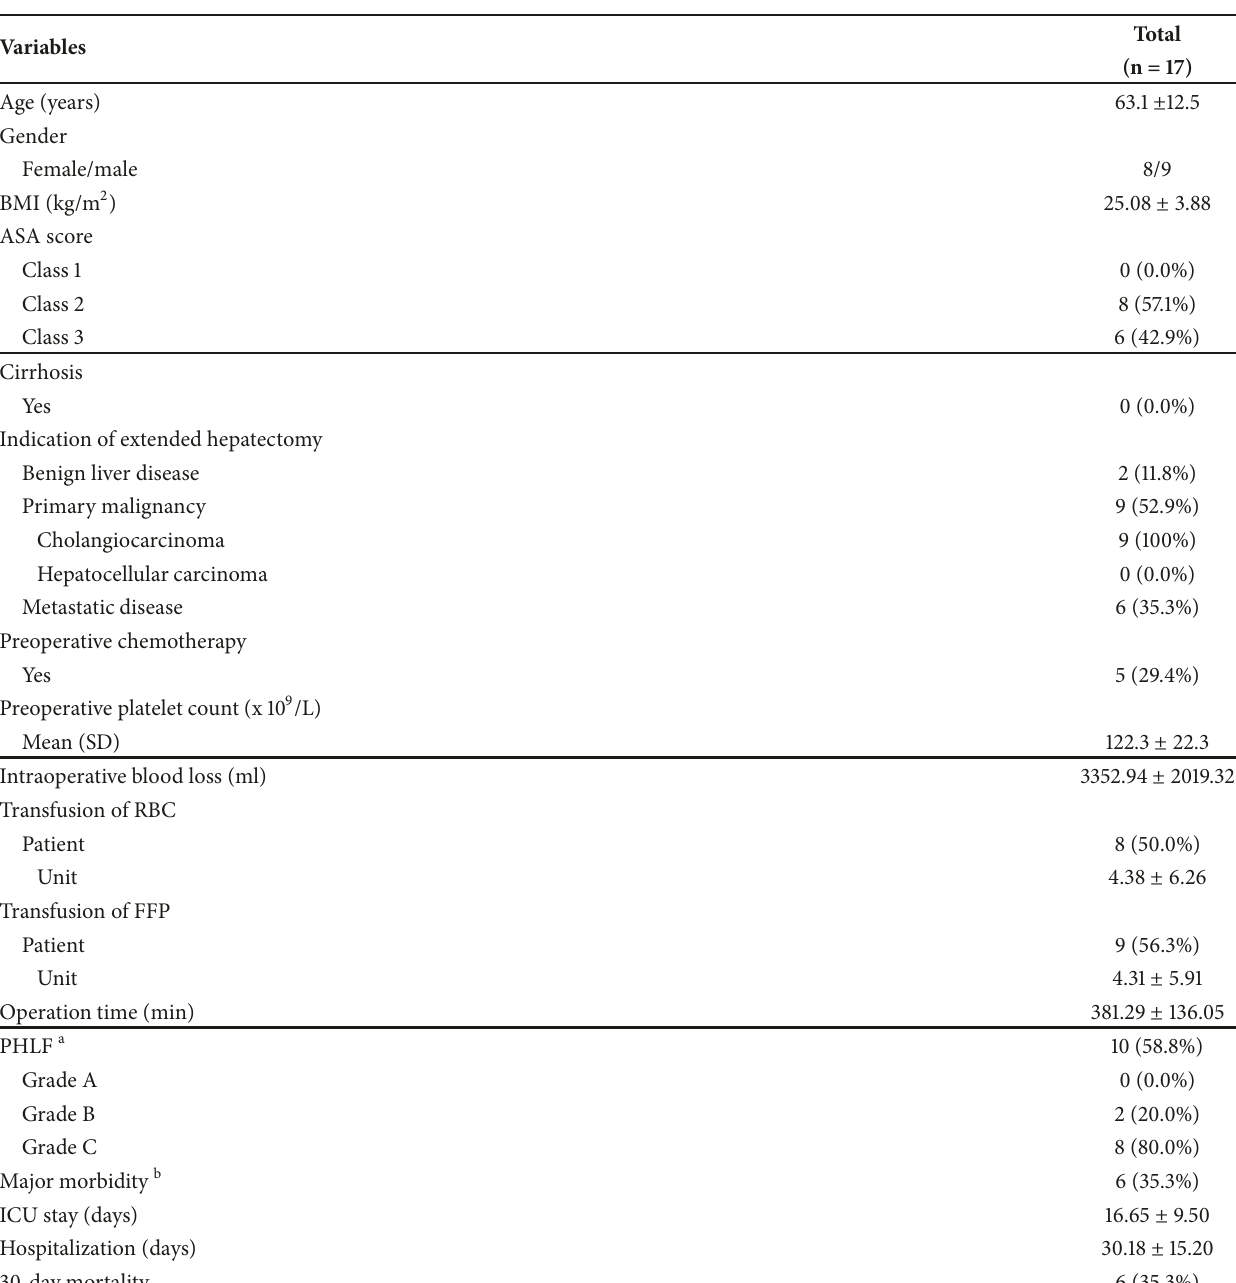
Table 2: Clinicopathologic characteristics of patients with a preoperative platelet count of < 150 x 10 9